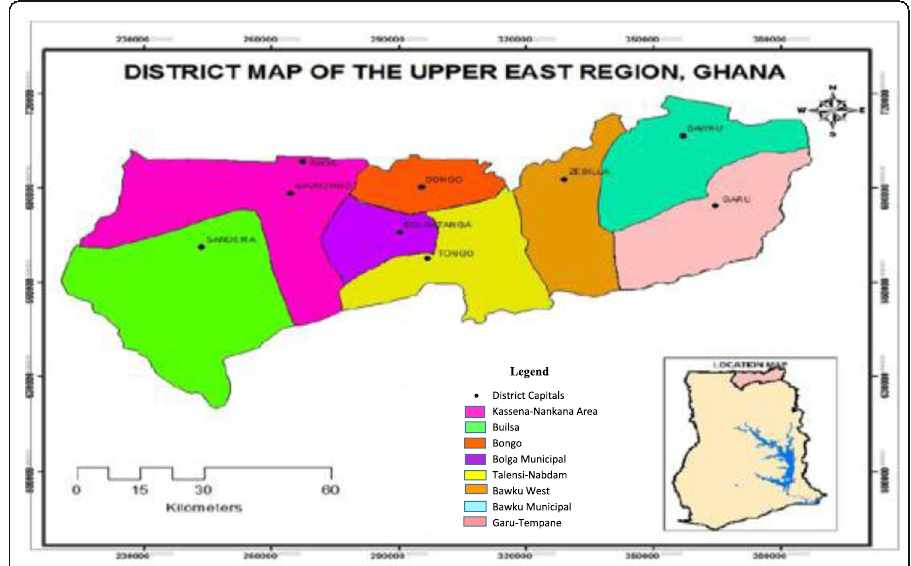
Fig. 1 A map of Kassena-Nankana Area in the Upper East Region of Ghana. Source: Dinye and Ayitio